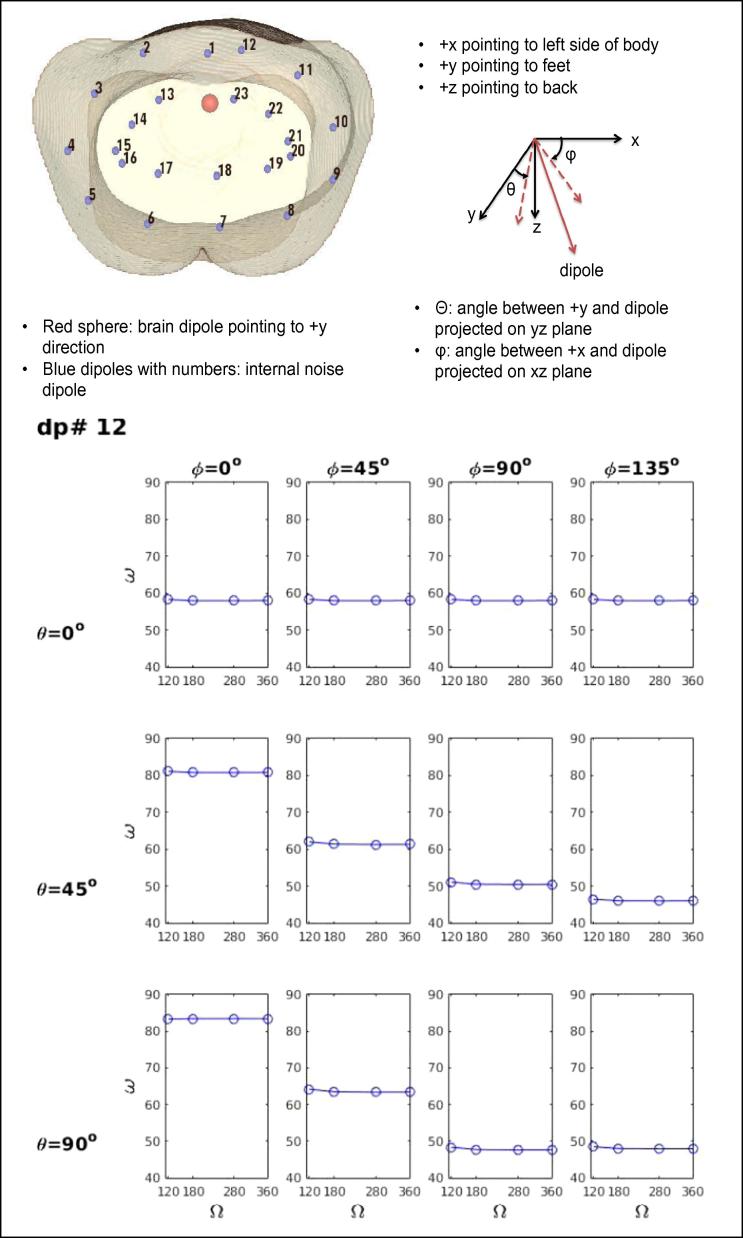
Subspace angle (ϖ) between the signal dipole (red sphere) and noise dipole 12 as a function of coverage angle of the sensor array (Ω) for different angular separations θ (angle between + y axis and the dipole projected on the yz plane) and ϕ (angle between + x and the dipole projected on xz plane). For this shallow noise dipole below the sensor array with the smallest coverage angle, ϖ is independent of Ω, but depends on θ and ϕ. Top inset shows the location of the signal dipole in the fetal brain (red sphere), pointing to feet, and 23 noise dipoles inside the torso.